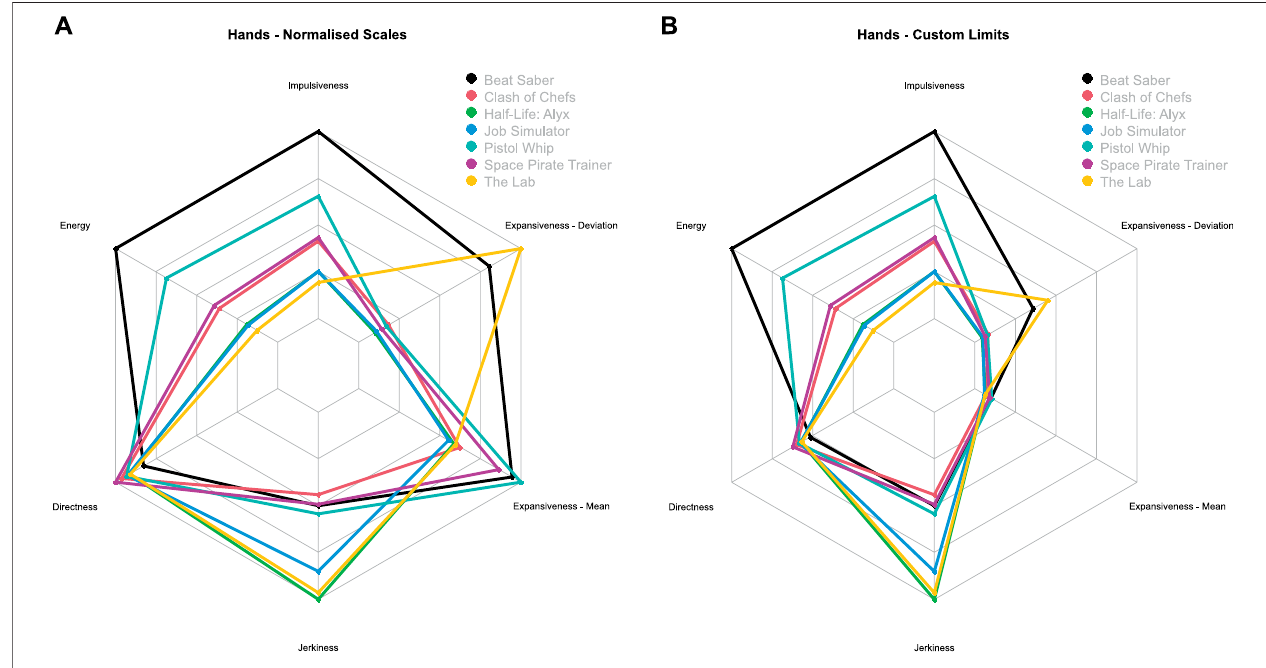
FIGURE3| Side-by-sidecomparisonofthecomputedoutcomewithnormalisedscales (A) andcustomscales (B) thatsetthemaximumvalueofthescaletoeither the mathematical upper limit (Directness) or to a theoretically calculated max value